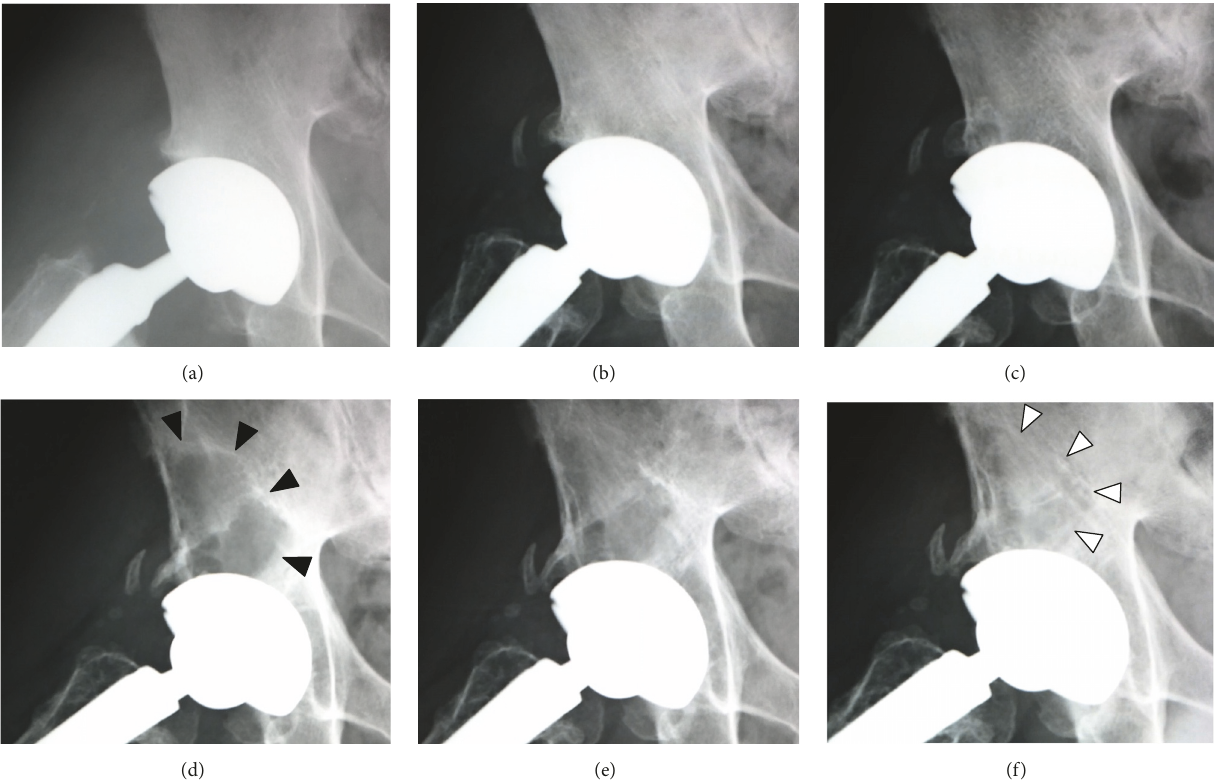
Figure 3: Lauenstein view of the right hip immediately after surgery (a) and at 2 (b), 4 (c), 6 (d), 8 (e), and 10 (f) years after surgery. After 4 years, acetabular osteolysis developed in zones 1 and 2 (black arrow heads), and the lesion was most significant at 6 years after surgery. However, most of the osteolytic area had been replaced by newly formed bone at 10 years (white arrow heads) without evidence of implant